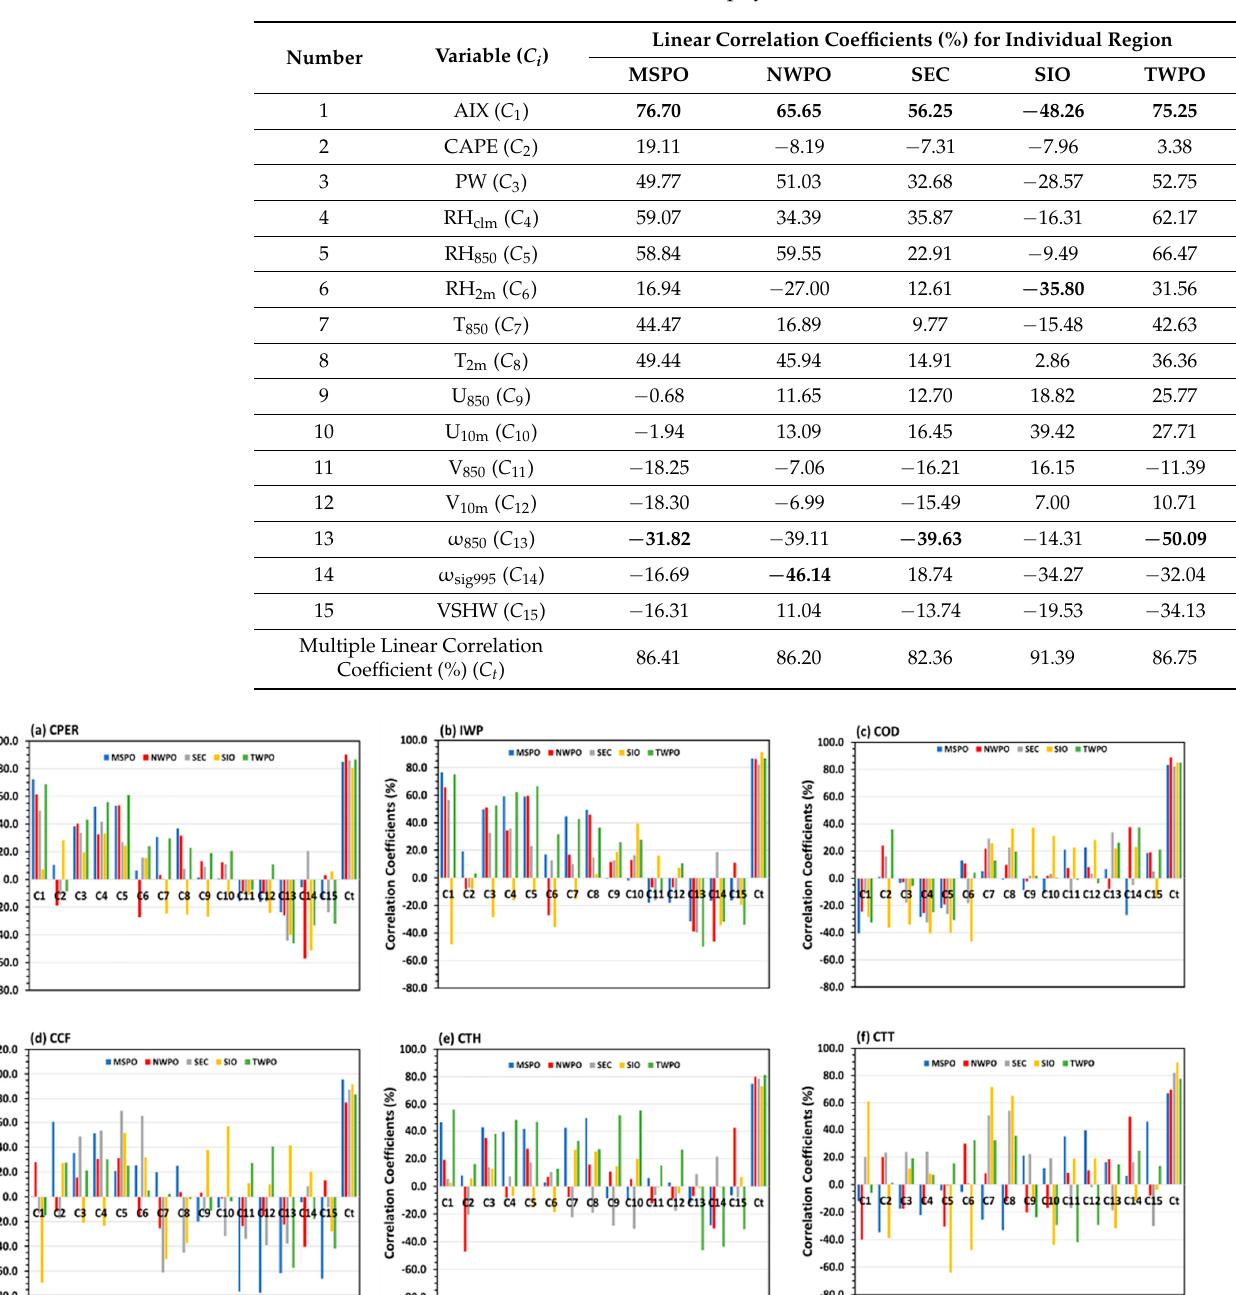
Figure 1). The correlation of cloud microphysical variable COD with AIX is not prominent and comparable to the correlation of COD with the relative humidity or the vertical motion (see Figure 7c), only becomes somewhat prominent in MSPO and TWPO but the absolute value of the correlation coefficient C 1 is still less than 50%. Thus, AIE signatures contained in COD variations may concealed by the covariance of meteorological conditions. Table 3. Same as Table 2 but for the cloud microphysical variable IWP.